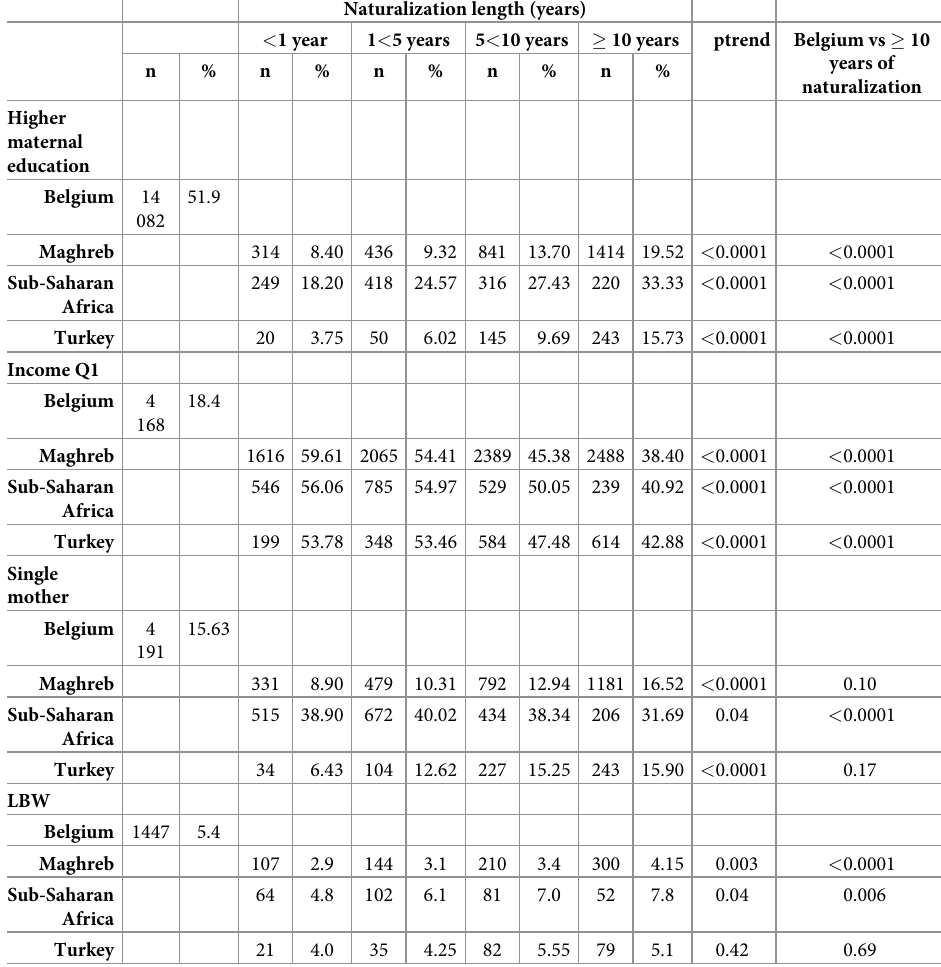
Table 2. Higher maternal education, poverty line (Q1 income) and single mother according to time since naturalization. Naturalization length